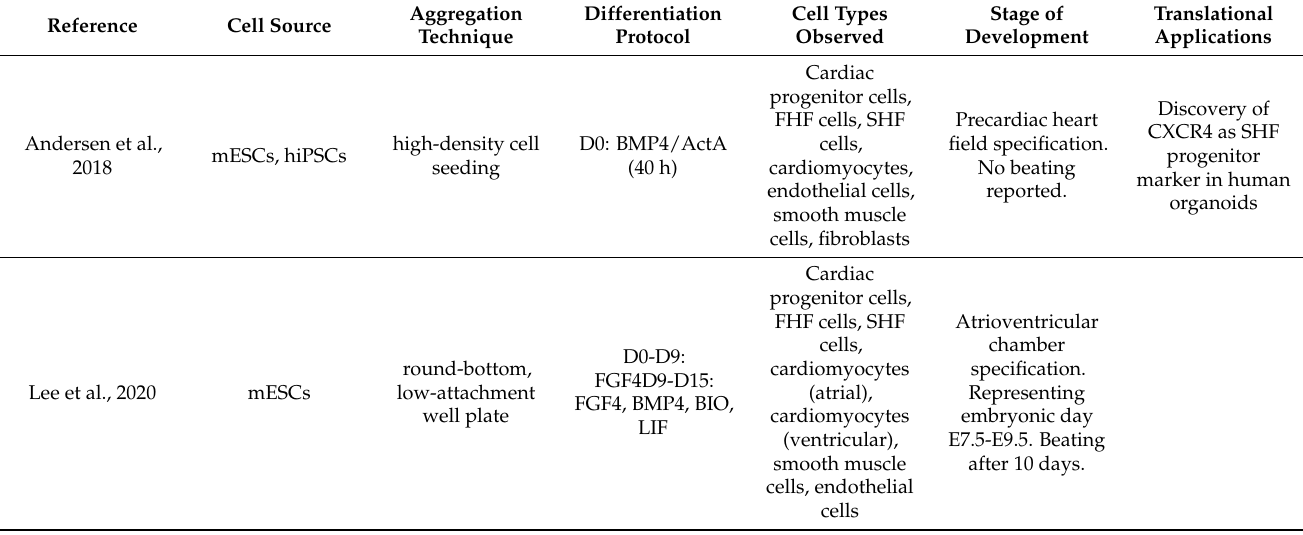
Table 2. Cardiac Organoids by Self-Assembly: techniques, characteristics, and